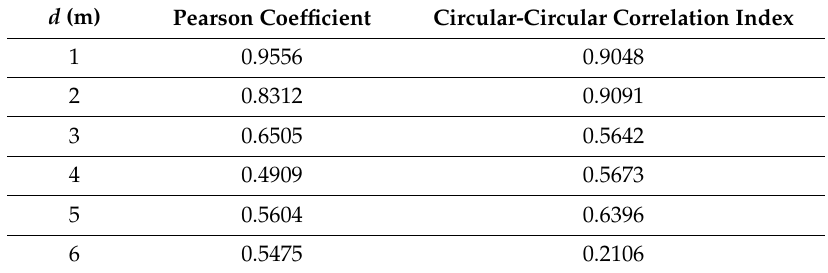
Table 1. Pearson coefficient of wind speeds and circular-circular correlation index of wind